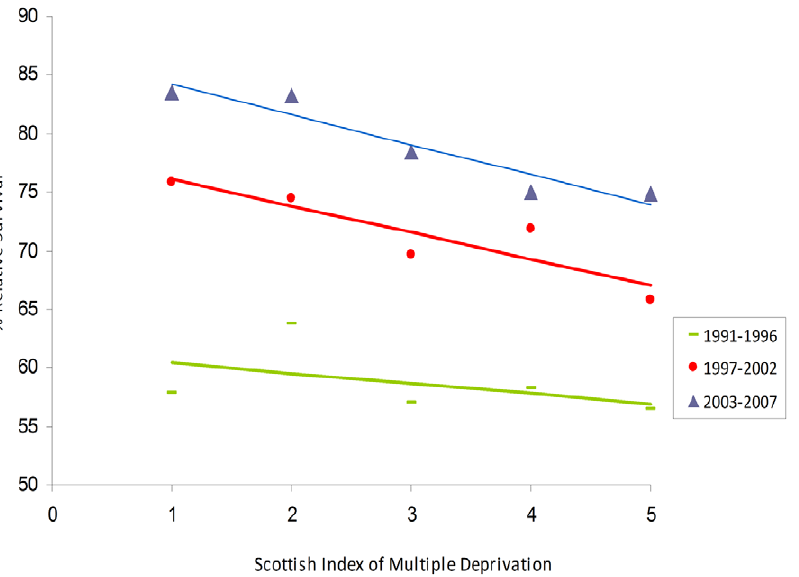
Figure 1. Deprivation gap in 5-year relative survival from prostate cancer from 1991–2007 in the West of Scotland. doi:10.1371/journal.pone.0056184.g001 PLOS ONE |